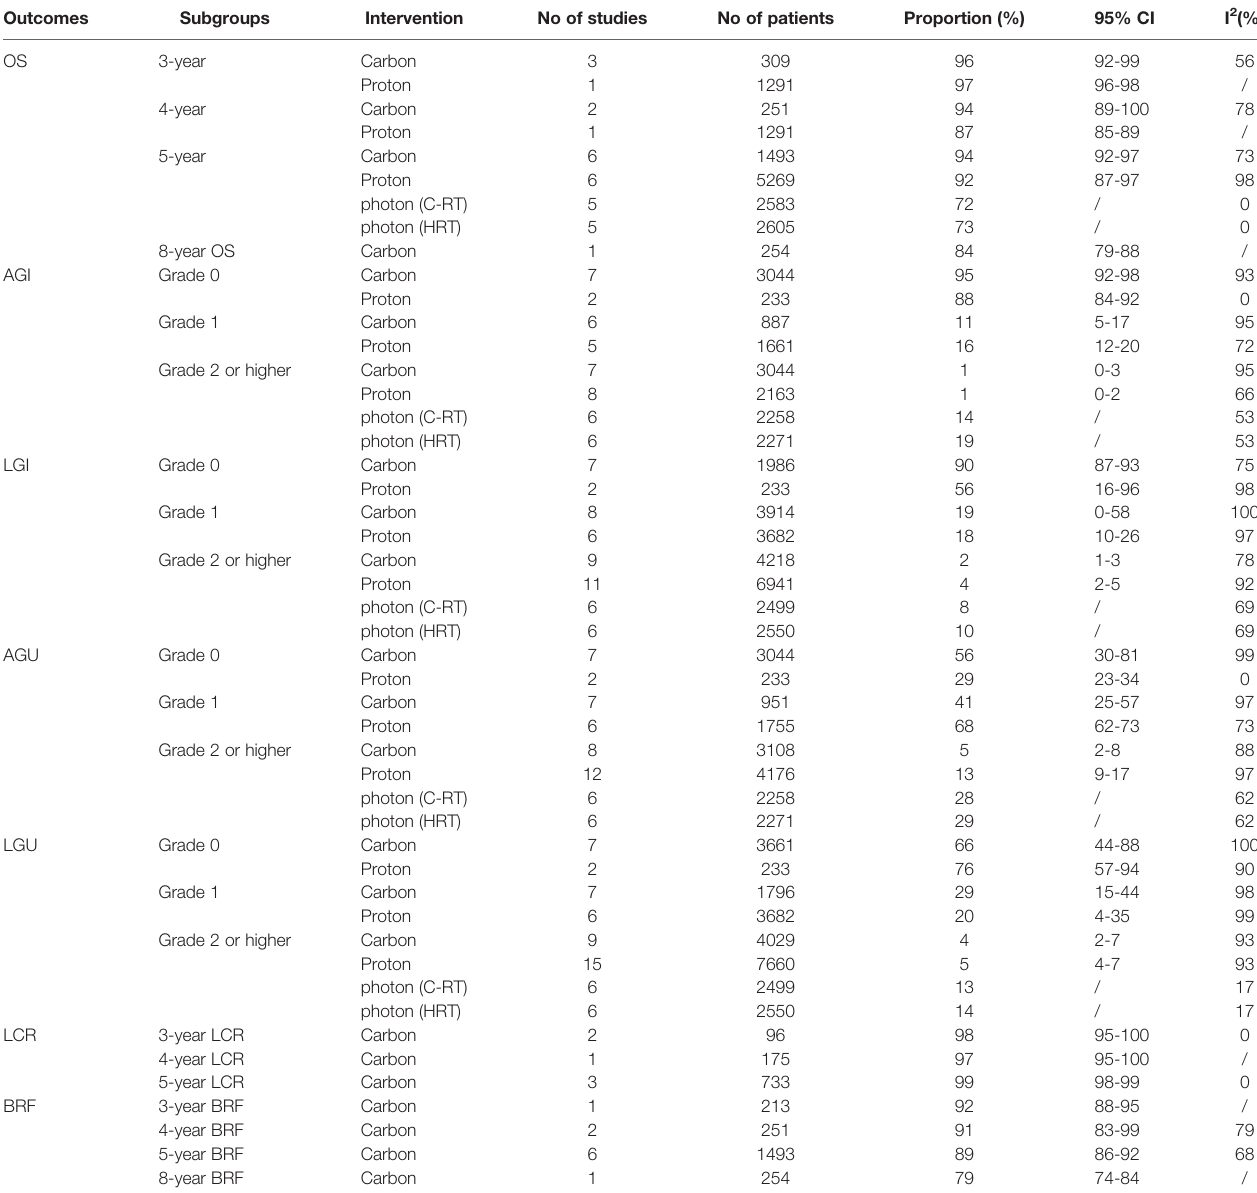
TABLE 3 | Meta-analysis